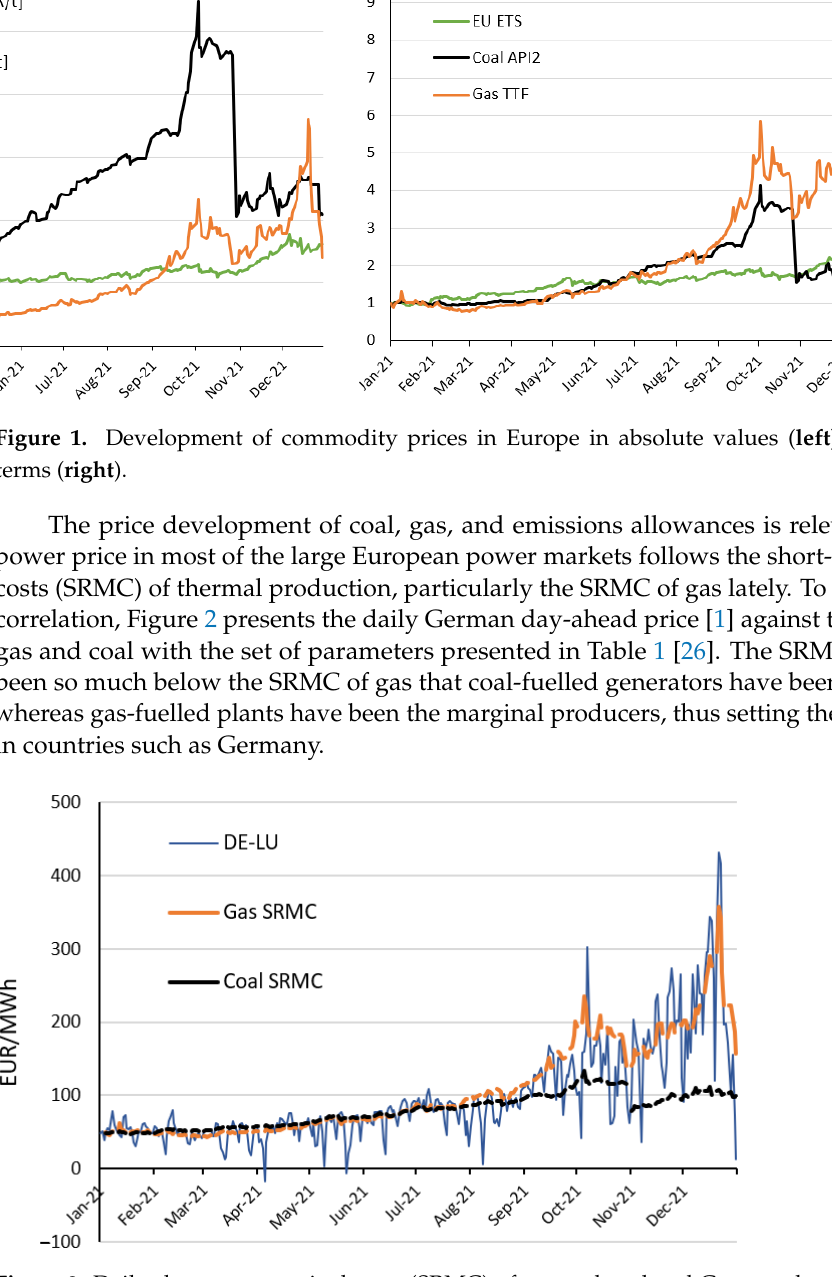
Figure 2. Daily short-run marginal costs (SRMC) of gas and coal and German day-ahead electric- ity